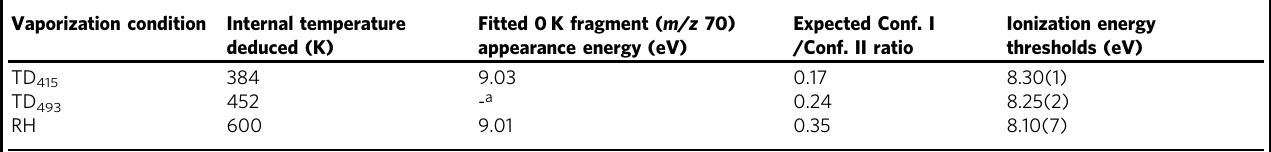
The 3rd column shows the Boltzmann expected Conf I/ Conf II population ratio based upon our calculated relative energies as shown in Table 1. The last column summarizes the apparent ionization energy threshold of the parent as deduced from Fig. 2. a For TD 493 the AE 0K was held at 9.03eV and only the slope was